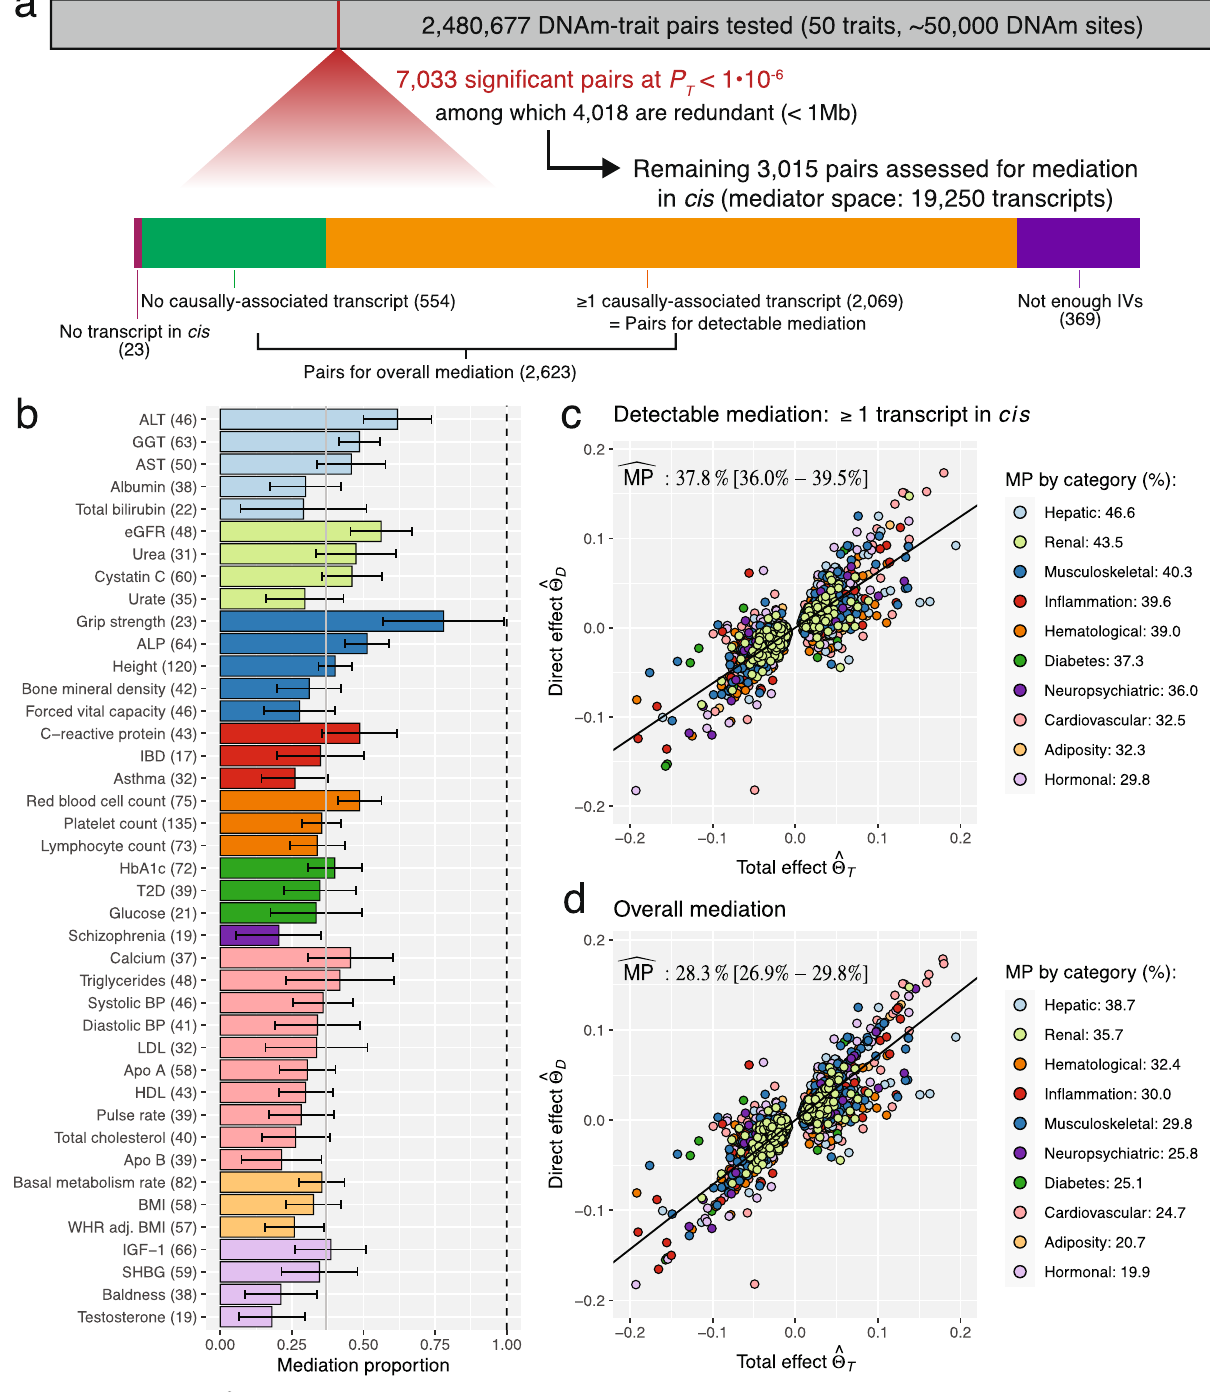
Fig. 3 | Mediation proportions ( d MP s) for transcriptsin cis mediating DNAm-to- trait effects. a Flowchart describing the selection of DNAm-trait pairs retained for mediationanalyses.Amongthetotalof2,480,677pairstested,2069pairs(orange) withasigni fi canttotalcausaleffect( P T )andatleast1causally-associatedtranscript were assessed for mediation ( b , c ). 554 pairswithout any transcript causally linked to the DNAmsite (green)were includedin the calculationofthe overallmediation. Pairs without any transcript in the cis region (pink) were omitted in mediation analysesaswerepairswithout suf fi cient instrumentalvariables(IVs, purple). b d MPs by trait where error bars denote the 95% CI, and the grey vertical bar shows the mean d MP acrossthetraits( d MPspertraitwerederived byregressing ^ θ D against ^ θ T ).